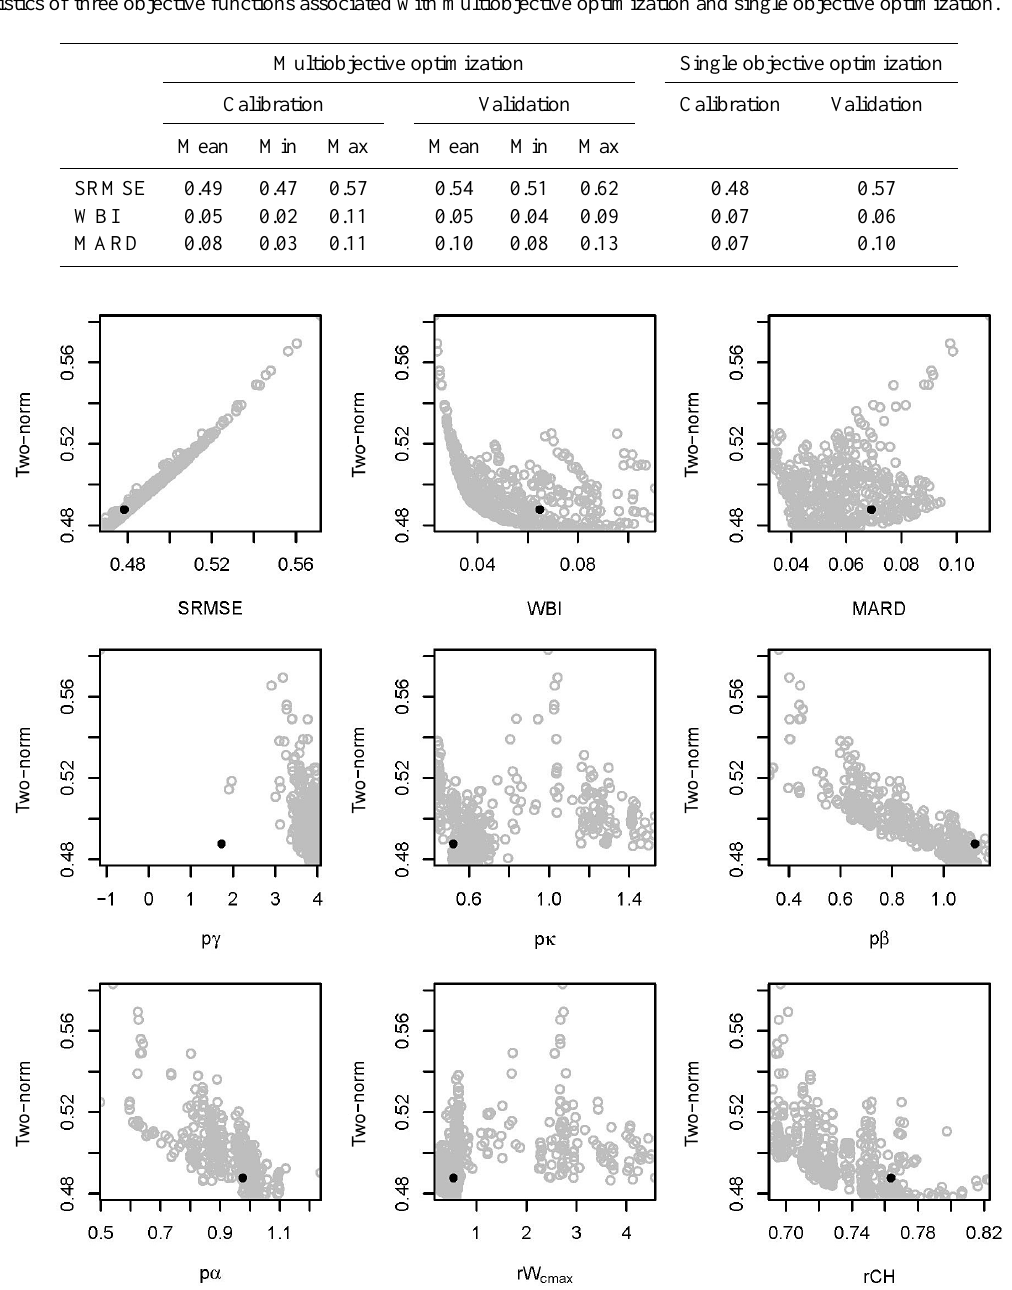
scale when computing objectives SRMSE and MARD.